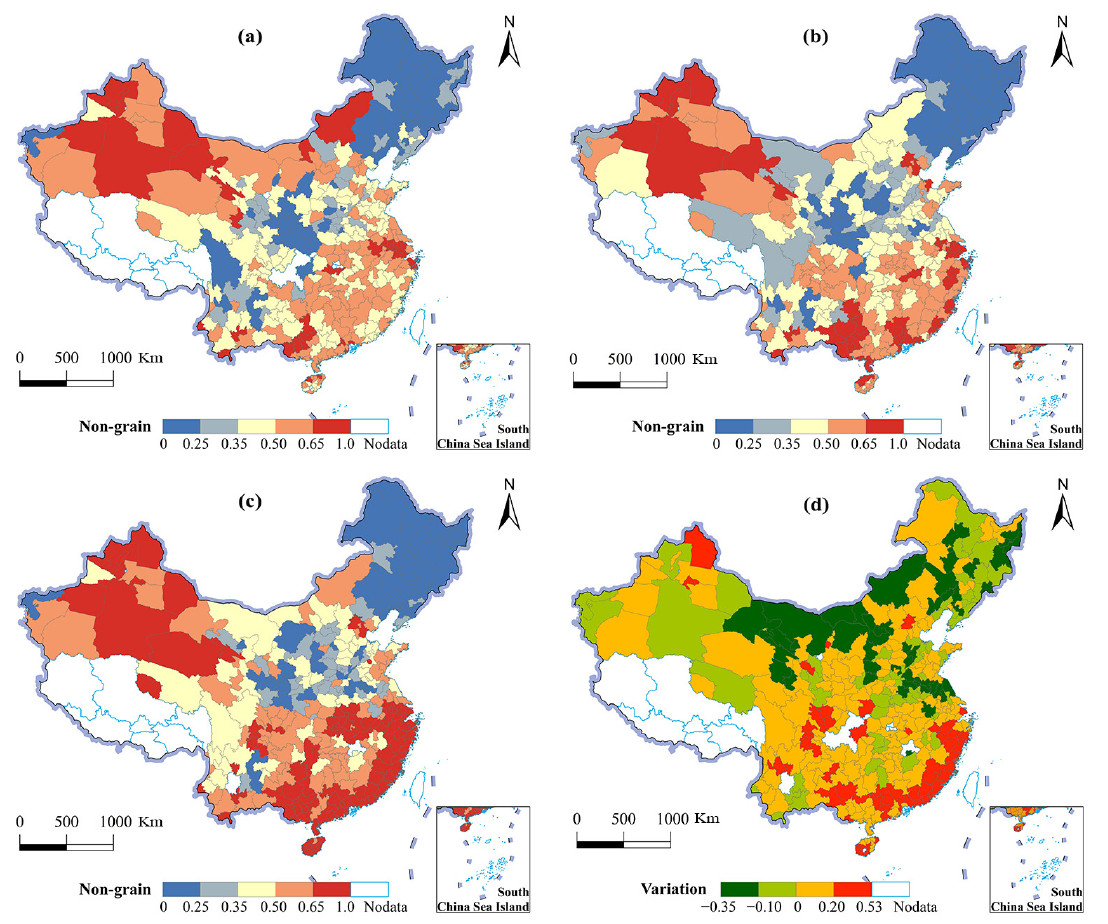
Figure 4. Spatial pattern evolution of NGPCL in China. ( a ) The NGPCL of China in 2000; ( b ) the NGPCL of China in 2010; ( c ) the NGPCL of China in 2020; ( d ) the spatial variation of NGPCL in China from 2000 to 2020.